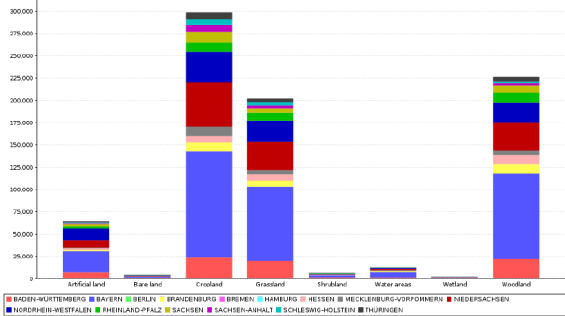
Figure 3: Land Use and Land Cover distribution in different Ger- man regions using LUCAS